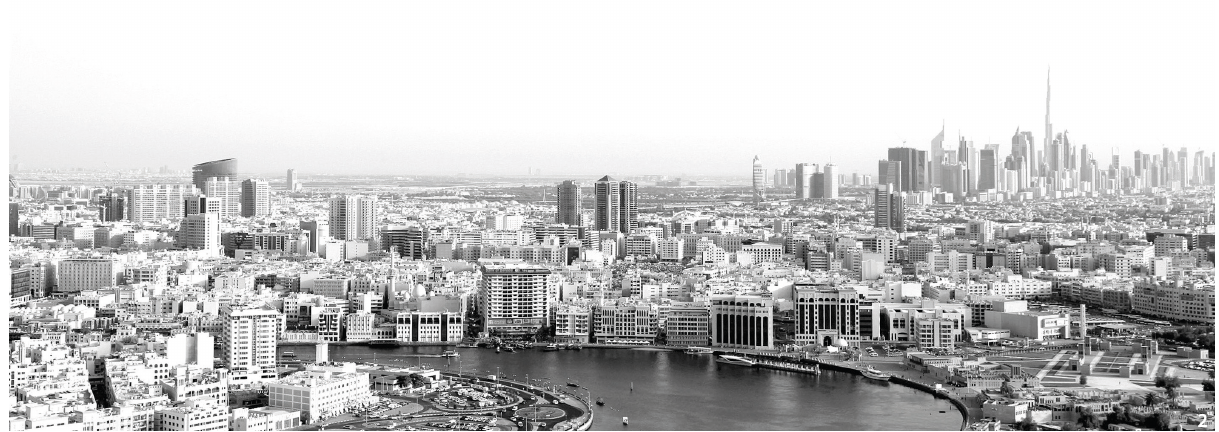
Figure 2 Skyline of modern Dubai, 2015 (Source: S.